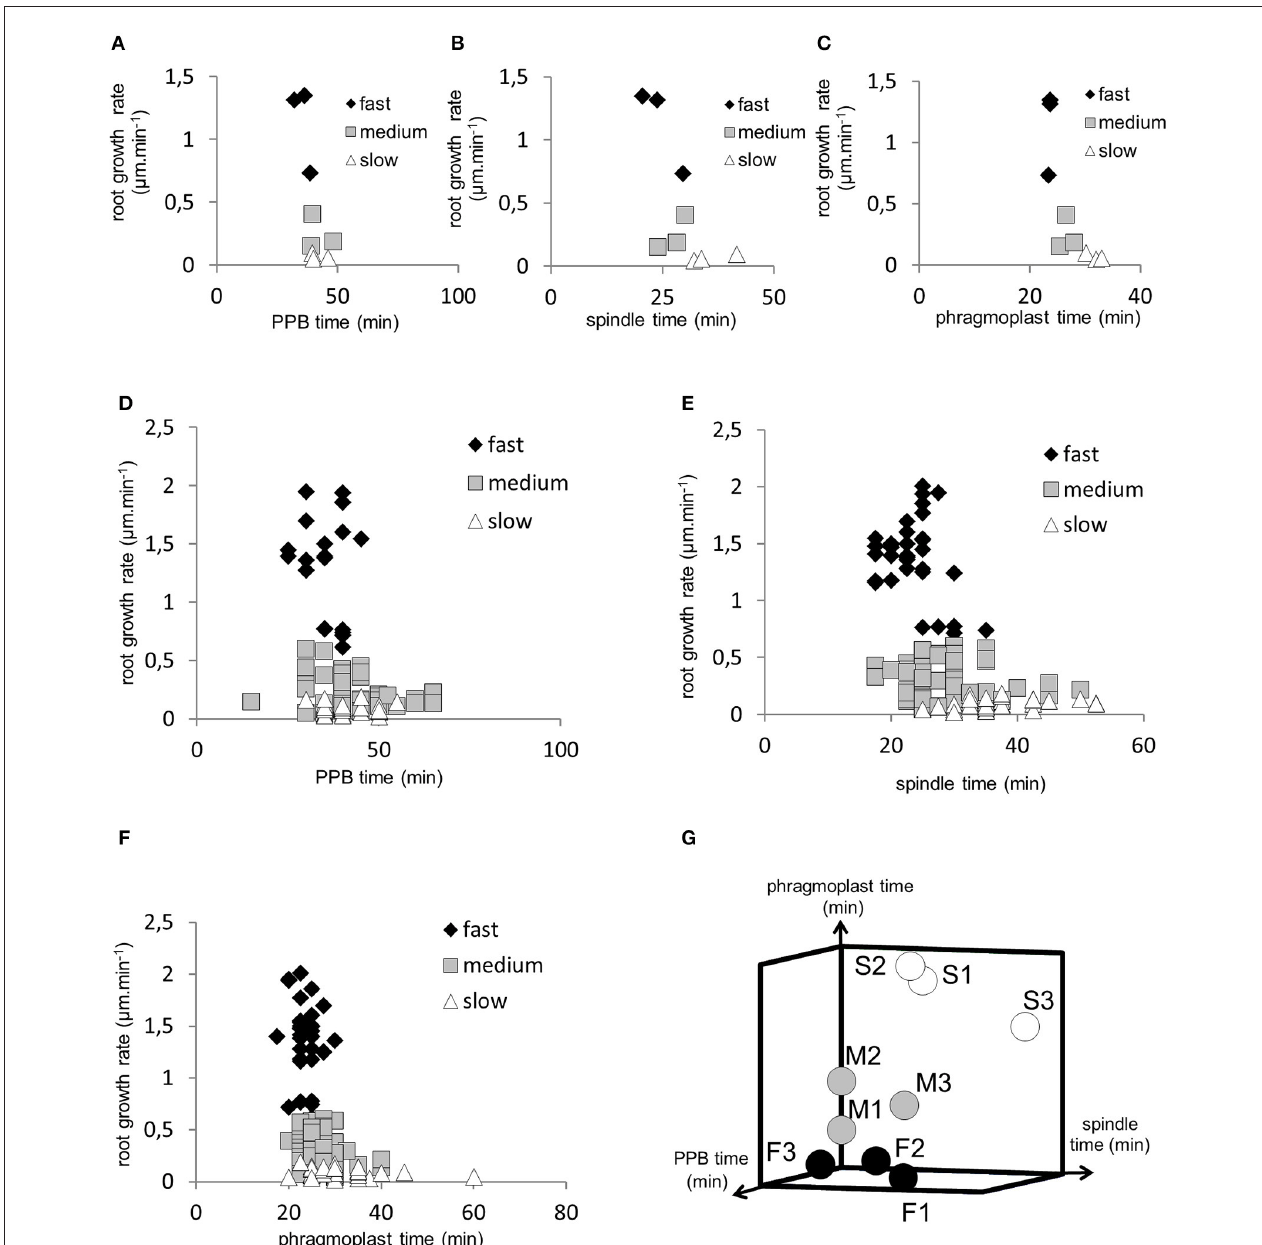
FIGURE 6 | Two- and three-dimensional visualization of data clusters for duration time of individual cell division stages in fast-growing, medium-growing and slow-growing roots according to root growth rate. (A–C) Distribution of clusters for average duration time of the PPB stage (A) , mitotic spindle stage (B) and phragmoplast stage (C) according to root growth rate in three fast-growing ( (cid:7) ), three medium-growing ( (cid:3) ) and three slow-growing ( 1 ) roots. (D–F) Distribution of clusters for duration time of the PPB stage (D) , mitotic spindle stage (E) and phragmoplast stage (F) according to root growth rate in all individual dividing cells of the fast-growing ( (cid:7) ), medium-growing ( (cid:3) ) and slow-growing ( 1 ) roots. (G) Visualization of data clustering for three fast-growing (F1, F2, F3), three medium-growing (M1, M2, M3) and three slow-growing (S1, S2, S3) roots according to cross-correlation between average duration time of the PPB stage, mitotic spindle stage and phragmoplast